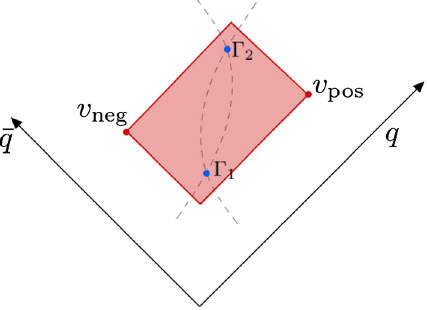
Fig. 31 Final breakup and final two hadrons of a q ¯ q system. The blue and red areas represent the two final hadrons while the green area cor- responds to the final region ˆ x + = ˆ x + + x + n , Old n , Had f